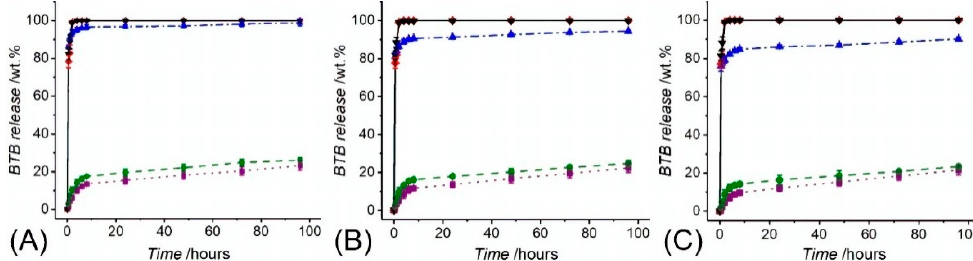
Figure 7. BTB release measured following incubation of samples PAA * (PMMA ‐ co ‐ MAA)30 ( A ), PAA * (PMMA ‐ co ‐ MAA)20 ( B ) and PAA * (PMMA ‐ co ‐ MAA)10 ( C ) at varied pH. ( ∙∙ ■ ∙∙ ): pH 5; ( ‐‐●‐‐ ): pH 6; ( ─ ∙ ▲ ∙ ─ ): pH 7; ( ─ ∙∙ ♦ ∙∙ ─ ): pH 7.4; ( ─▼─ ): pH 8.